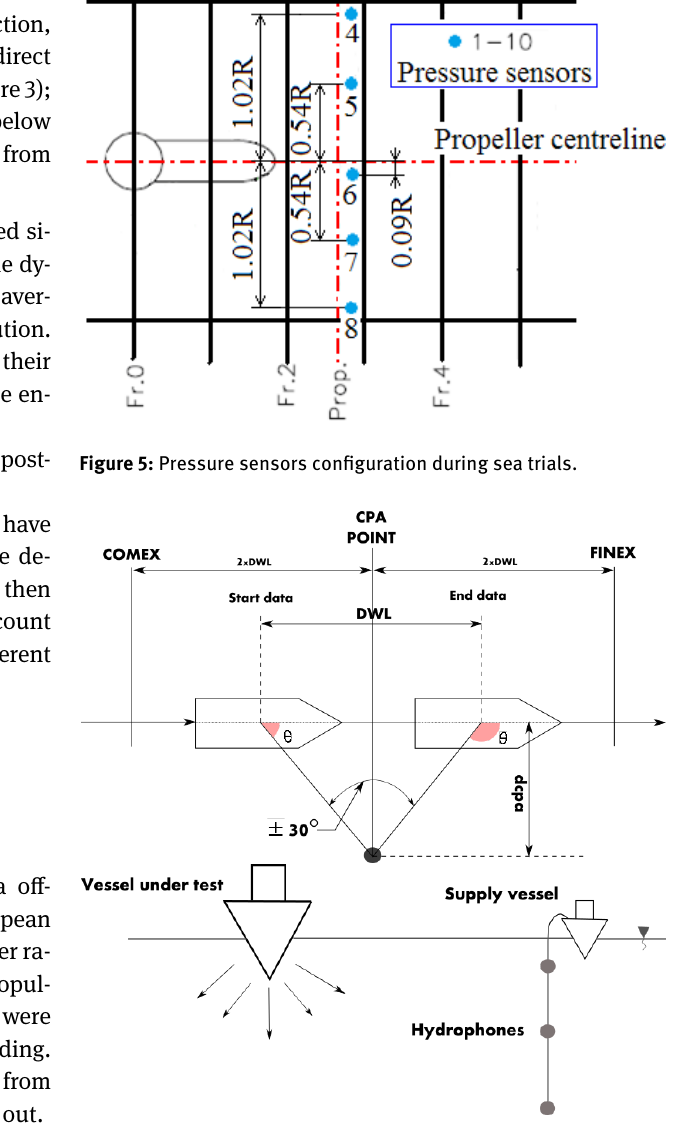
Figure 6: Measurement test layout as suggested in ANSI/ASA 2009 (top: horizontal view, bottom: vertical